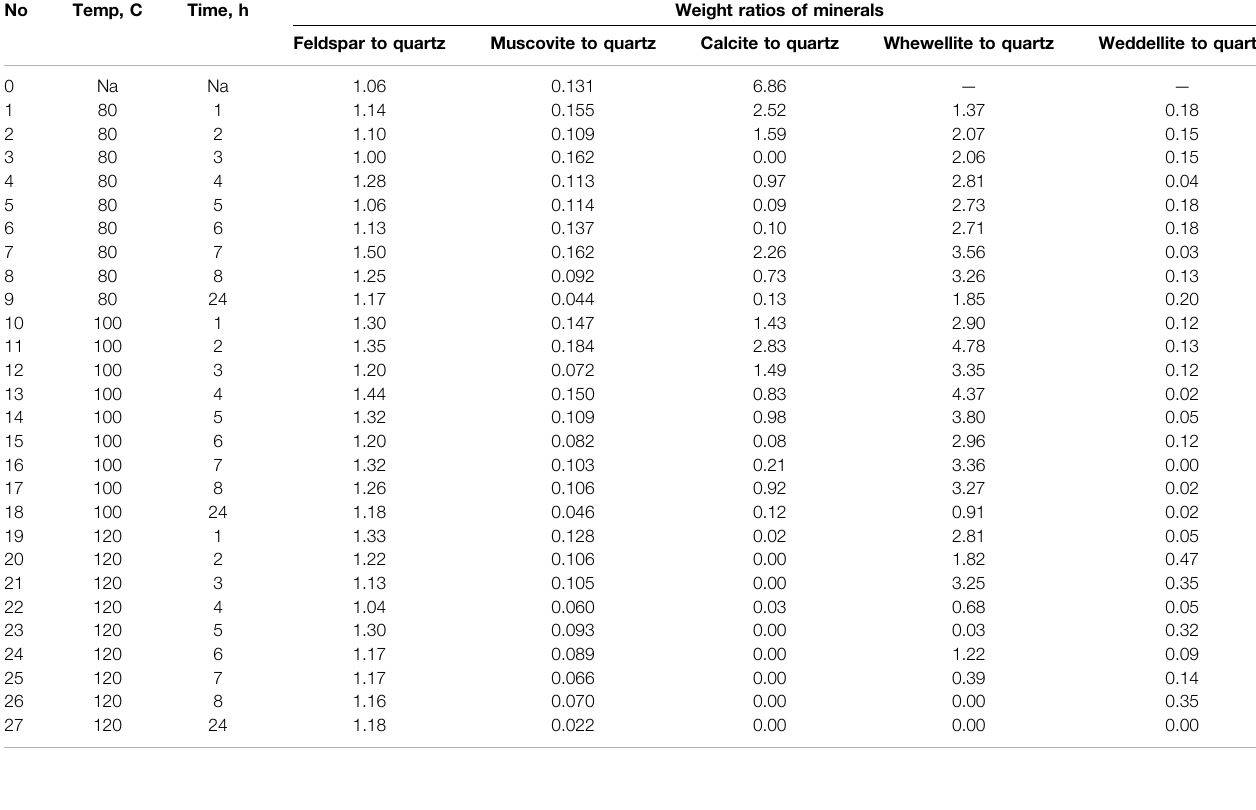
TABLE 3 | Weight ratios of minerals in solid samples.